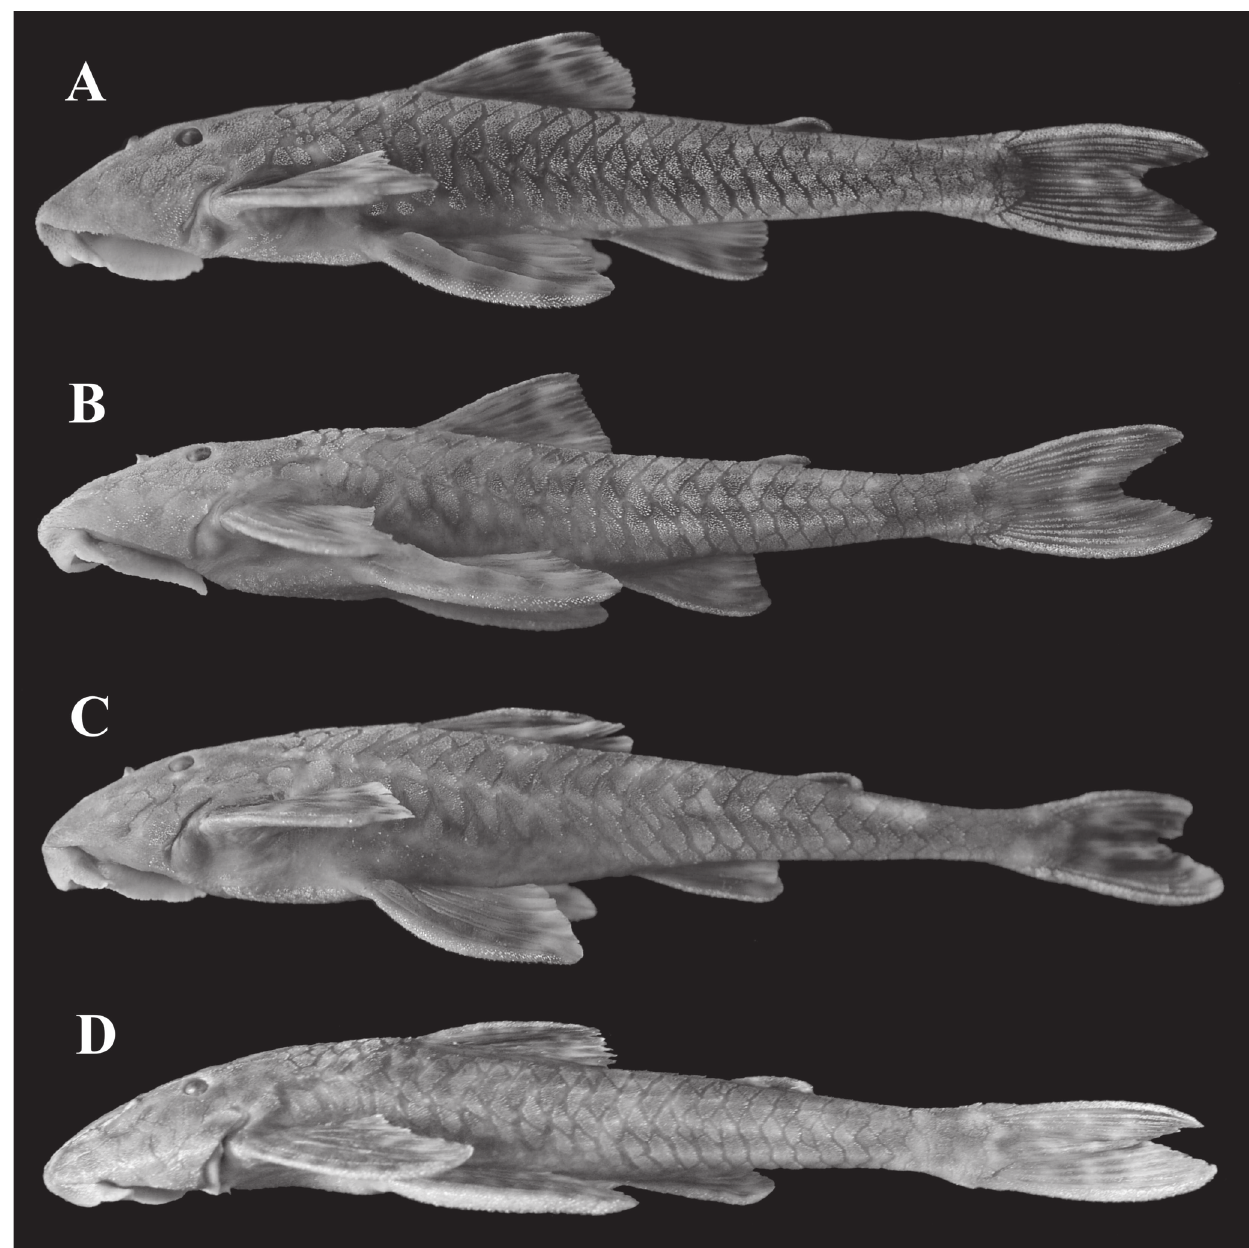
Fig. 2. Lateral view of four specimens of Neoplecostomus yapo from the following localities: A, ribeirão Atlântico, 85.9 mm SL; B) ribeirão Uraí, 93.3 mm SL; C) rio Verde, 96.0 mm SL; and D) rio Fortaleza, 97.4 mm SL (type locality of N. yapo